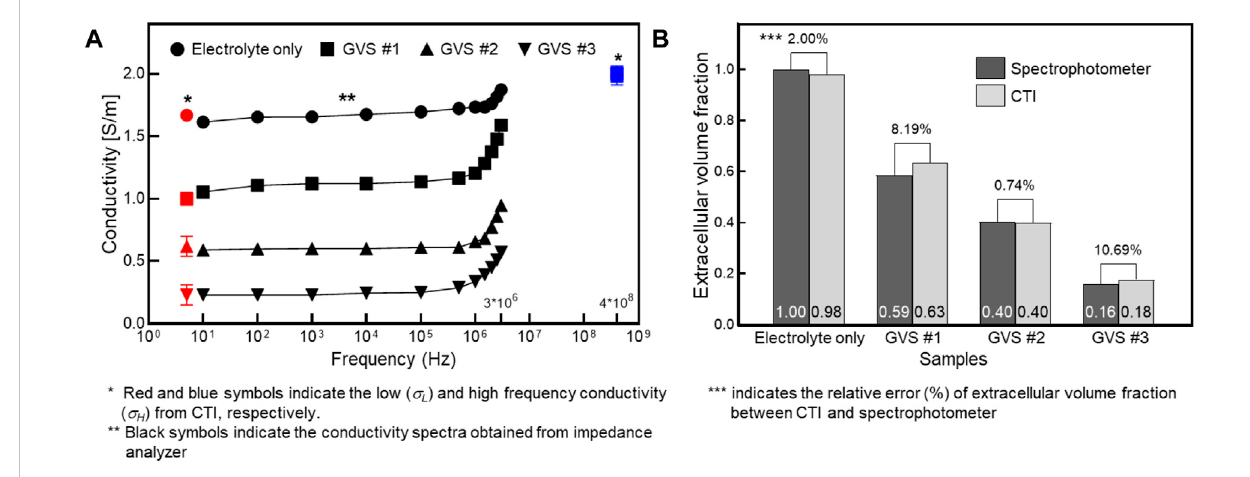
FIGURE 5 Comparison of the conductivity between CTI and in vitro measurement (A) and comparison of the extracellular volume fraction between CTI and spectrophotometer (B) depending on four different GVS densities.